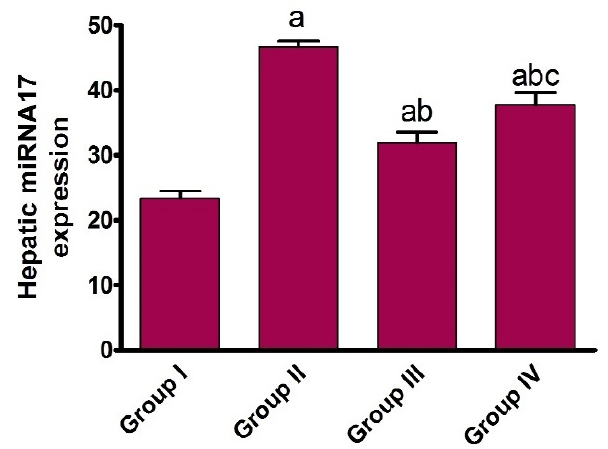
Figure 4. Effect of carvedilol on miRNA-17 expression in hepatic ischemia associated with isoprenaline-induced AHF. Group I: naïve, Group II: control positive, Group III: pre-treated carvedilol, Group IV: post-treated carvedilol. Data presented as mean ± SEM. a p < 0.05 versus group I, b p < 0.05 versus group II, c p < 0.05 versus group III.